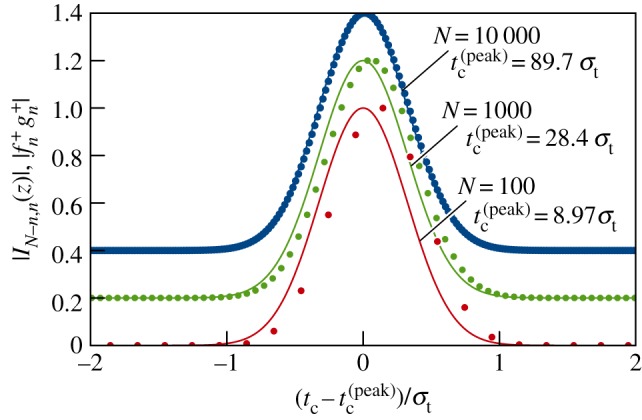
|IN−n,n(z)| plotted as a function of the scaled clock time (tc−tc(peak))/σt, where tc=(2n−N)δt. The points (|IN−n,n(z)|,(tc−tc(peak))/σt) are generated parametrically by varying n. The dots represent the exact values from equation (3.10), and the solid curves represent the approximation given by |fn+gn+| in equation (3.19). The numerical values used are z=θ/N, where θ=2.23π and N=100 (red), N=1000 (green) and N=10 000 (blue). For clarity, the functions have been scaled to give a maximum of unity, and the green (N=1000) and blue (N=10 000) dots and curves have been displaced vertically by 0.2 and 0.4, respectively. Note that the value of t(peak)c varies as N.